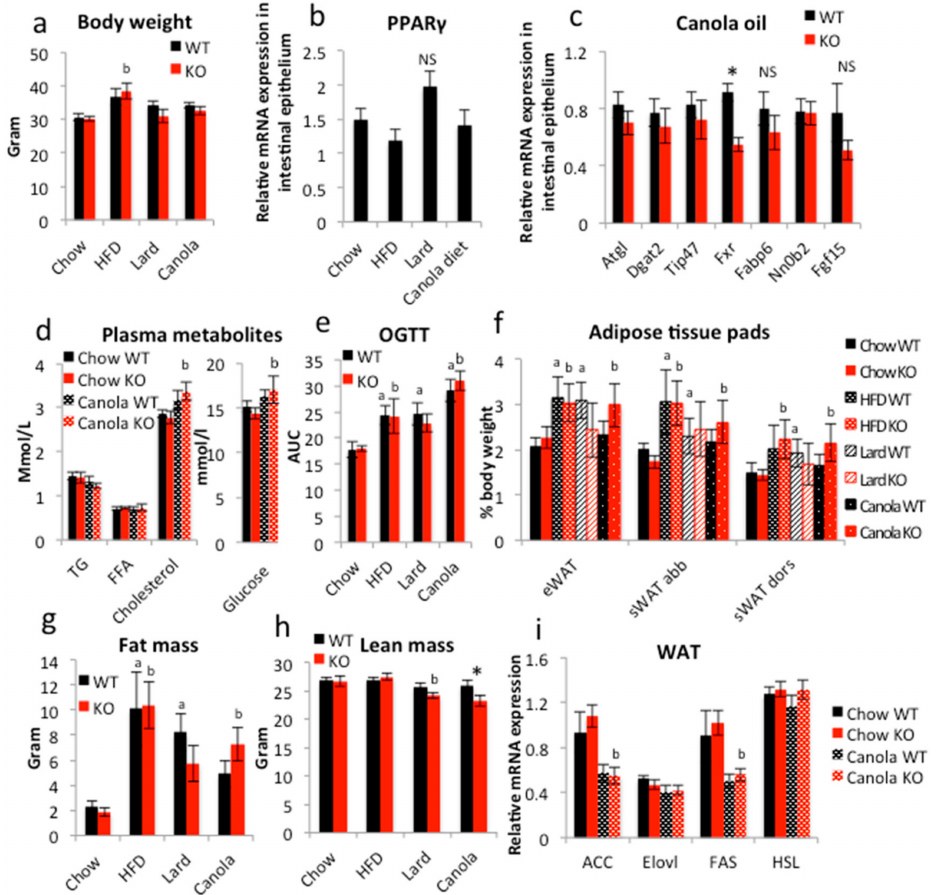
Figure 2. Long-term exposure to canola oil triggers mild body composition changes in iePPAR γ KO vs. WT mice. ( a ) Body weight of mice fed chow, high fat diet (HFD), lard diet, or canola oil diet ( n = 7–10). ( b ) The relative mRNA expression levels of PPAR γ and ( c ) lipid metabolism-associated genes in the duodenal epithelium were assayed by RT-qPCR ( n = 9–18). ( d ) Concentration of TGs, FFAs, cholesterol, and glucose in plasma of mice fed chow and canola diet ( n = 7–12). ( e ) Mice were submitted to oral glucose tolerance test (OGTT) and their plasma glucose levels monitored over 2 h ( n = 5–9). ( f ) Weight of epididymal white adipose tissue (eWAT), subcutaneous abdominal WAT (sWAT